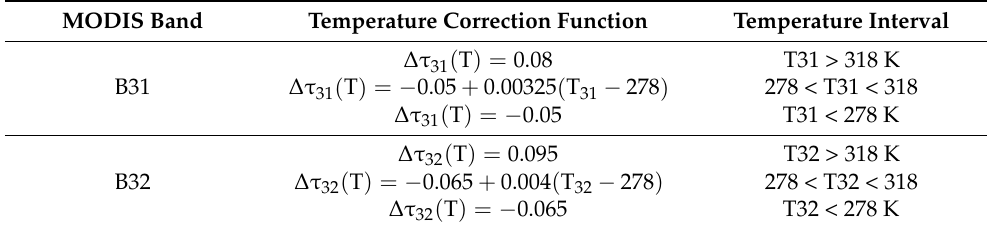
Table 2. Temperature correction function for atmospheric